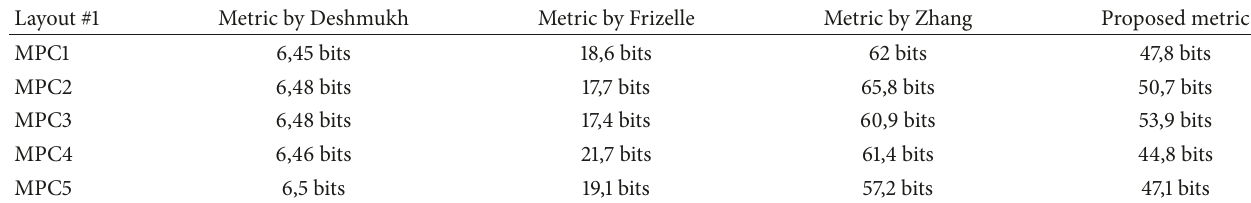
Table 13: Comparison of static complexity values for Layout